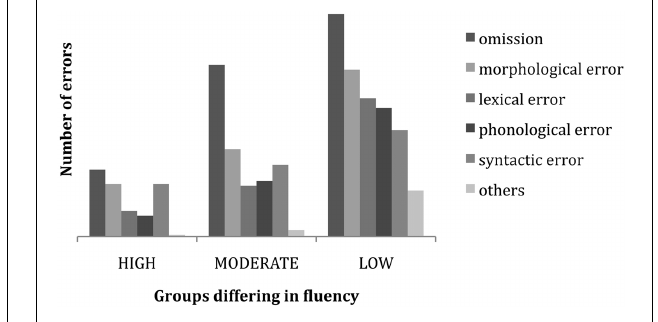
FIGURE 4 | Incidence and relative proportion of error types by hearing status and age.